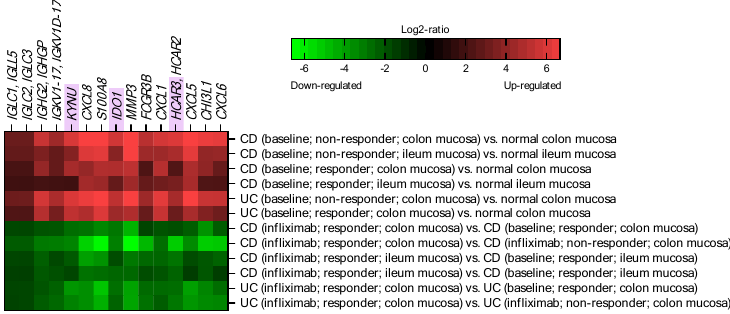
Figure 1. Genes differentially regulated during the course and treatment of inflammatory bowel disease (IBD). Genes identified to undergo marked upregulation in IBD and to be markedly down- regulated in response to successful infliximab treatment (|log 2 -ratio| ≥ 1.6). Genes from kynurenine pathway are highlighted in purple. IBD, inflammatory bowel disease; CD, Crohn’s disease; UC, ulcerative colitis.